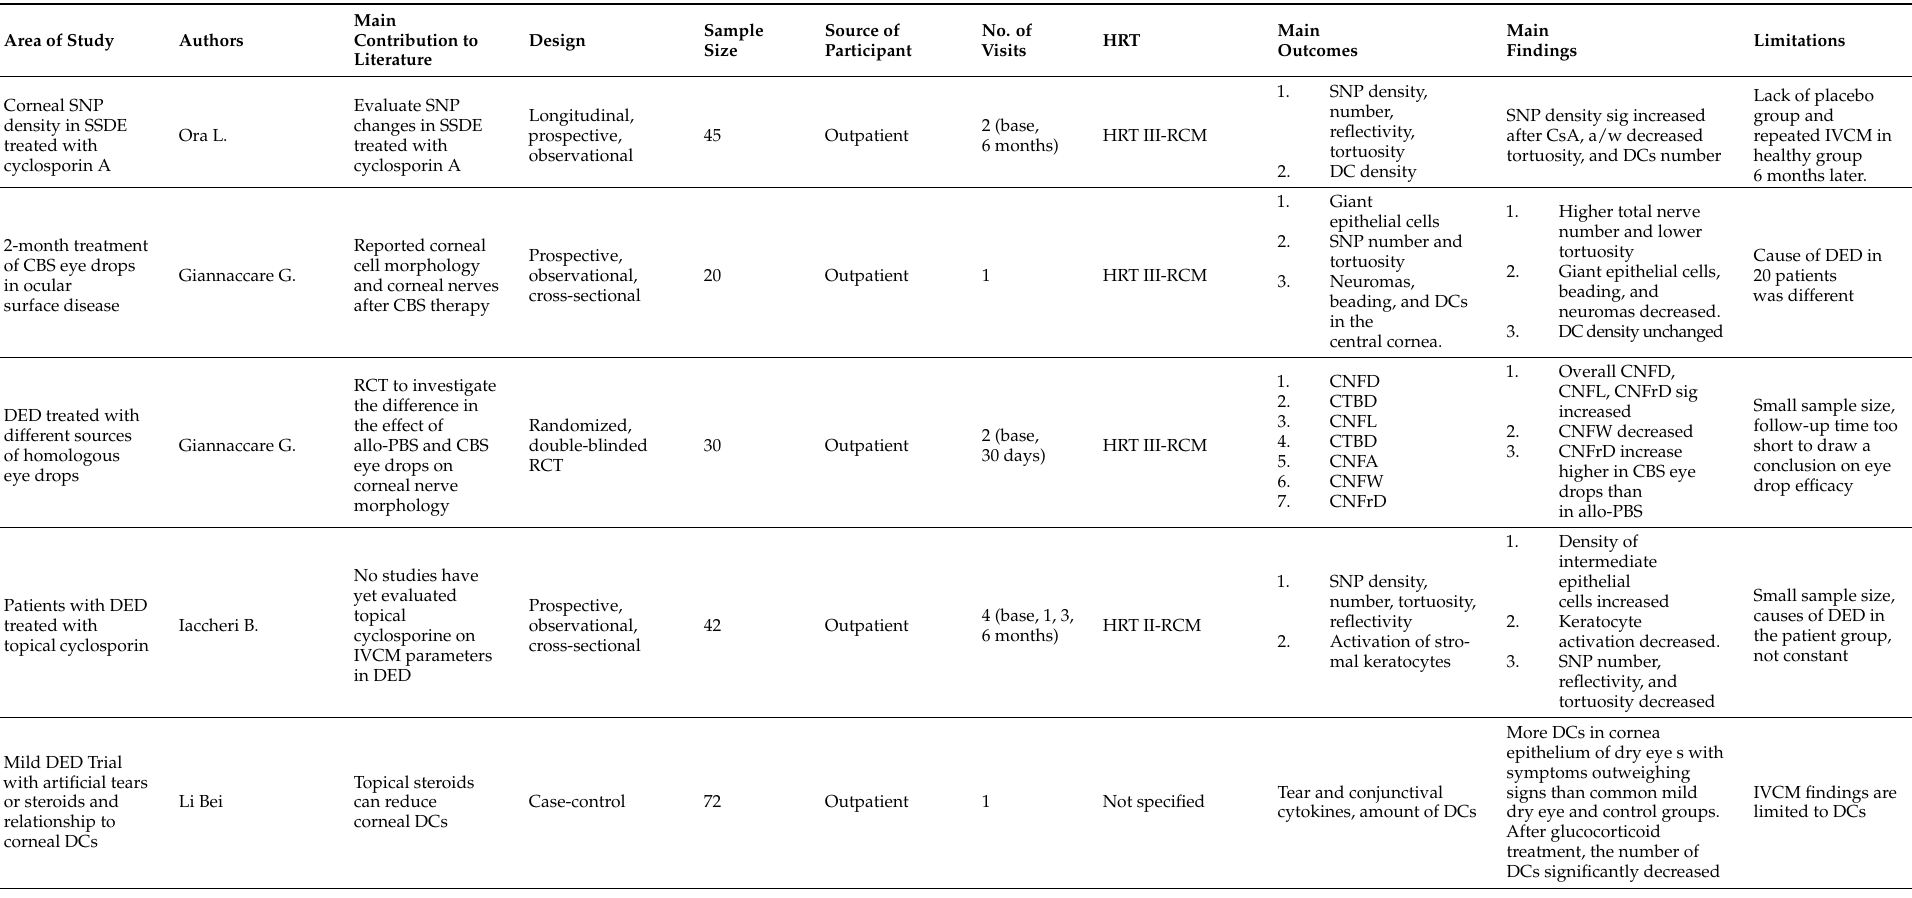
Table 3. Studies on Treatment-Induced Changes in Dry